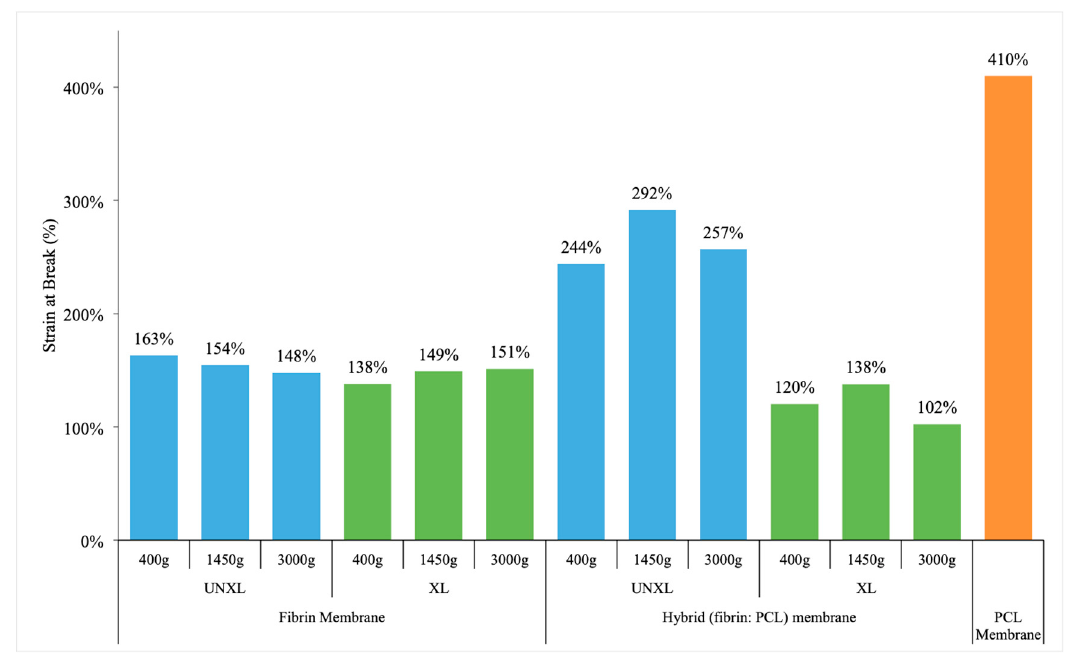
Figure 7. Strain at break of fibrin membrane, hybrid membrane and pure PCL membrane. Data shows fibrin membranes stretch approximately 50% of its original length. Hybrid membranes, especially those that are not crosslinked have significantly increased strain before break (more than twice its original length). Crosslinking decreases the ability of the membranes to stretch as expected. Key: UNXL: uncrosslinked; XL: crosslinked.